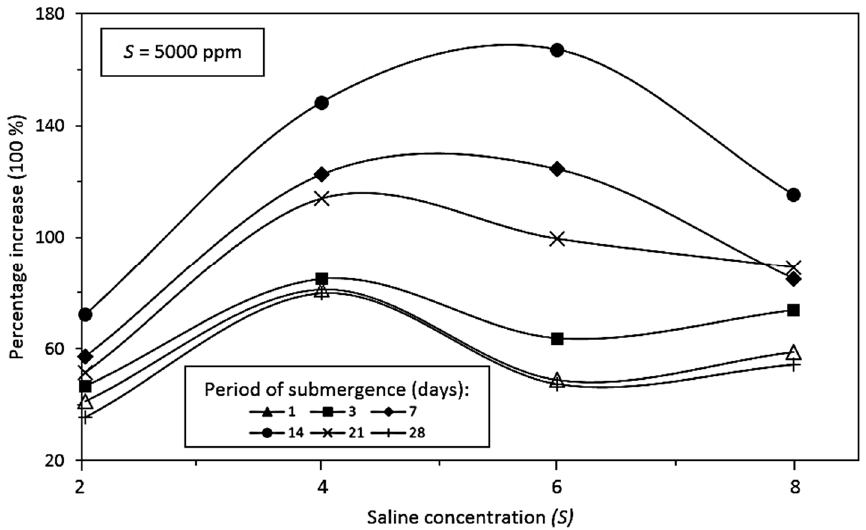
Figure 14. Variation of percentage increase in permeability with saline concentration.